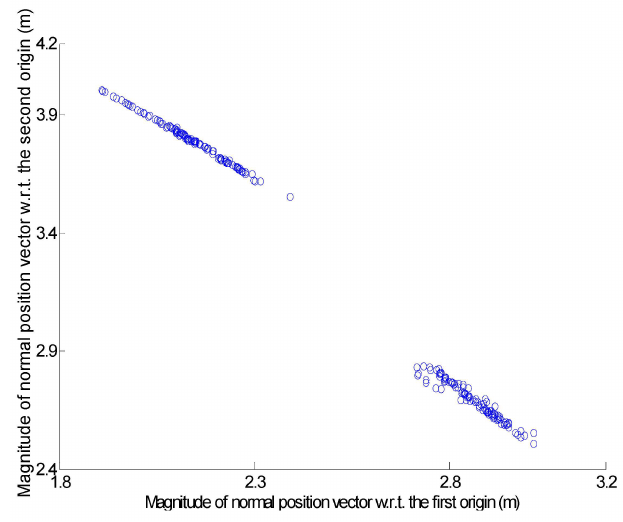
Figure 10. Scatter plot after resolution of ambiguity